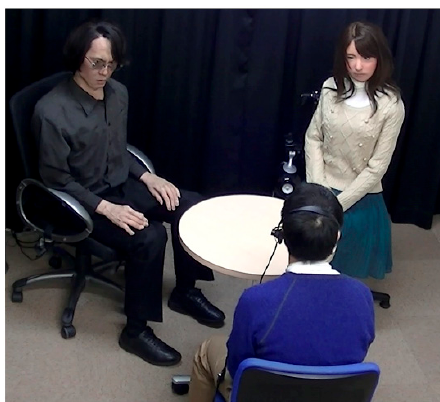
Figure 4. A scene of the experiment.